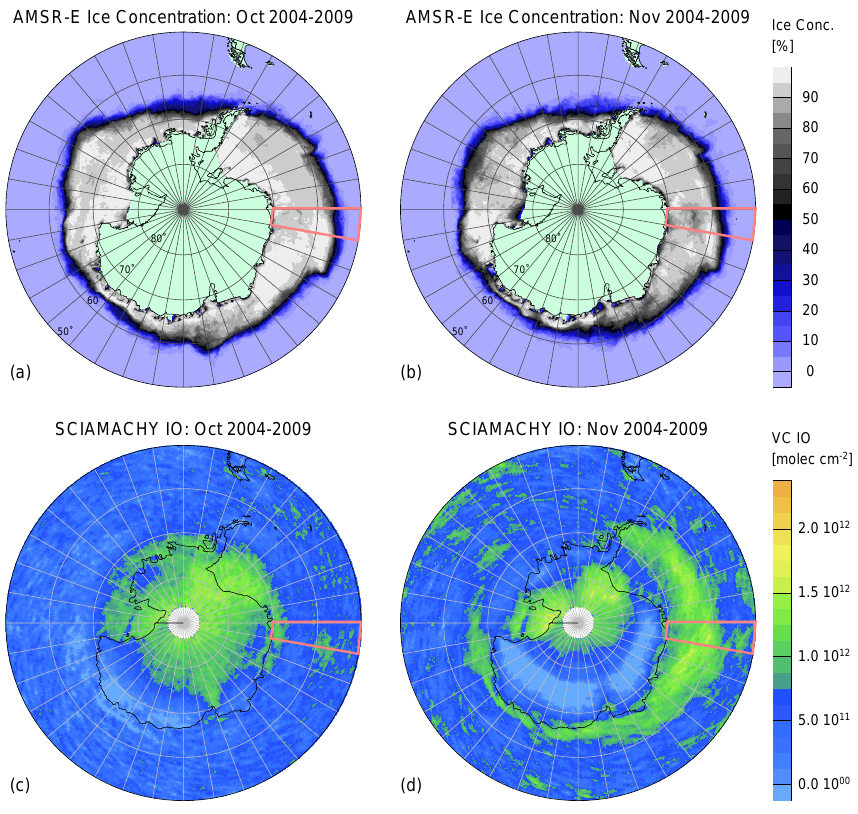
Fig. 8. Maps of the sea ice concentration above Antarctica in October (a) and November (b) , averaged over the years 2004 to 2009 each, i.e. the same time period as in Figs. 4 and 5. Data of daily sea ice concentrations are available from the Integrated Climate Data Center (ICDC, http://icdc.zmaw.de, KlimaCampus, University of Hamburg). The boxes mark an example area with internal ice concentration loss between October to November, which is used for analysis in Fig. 9. For comparison, the IO maps for October (c) and November (d) have been repeated here from Fig. 4. 39